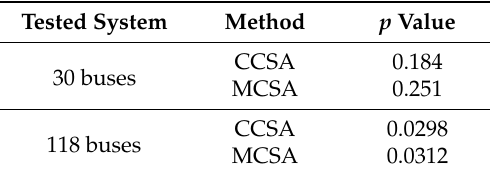
Table 7. The p values of Wilcoxon’s rank-sum test for pairwise